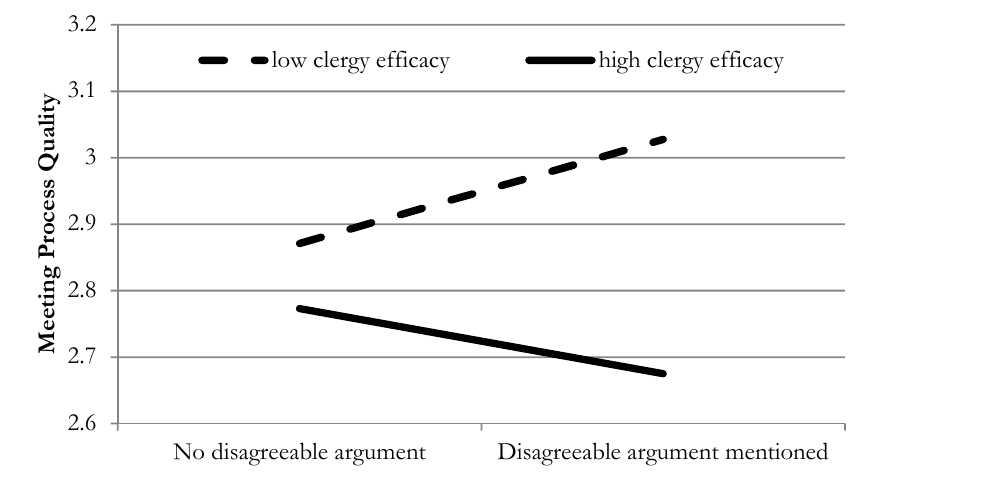
Figure 5 : Interactive Effect of Clergy Efficacy and Clergy Mentioning a Disagreeable Argument on the Perceived Process Quality in the Congregational Meeting on the Vote